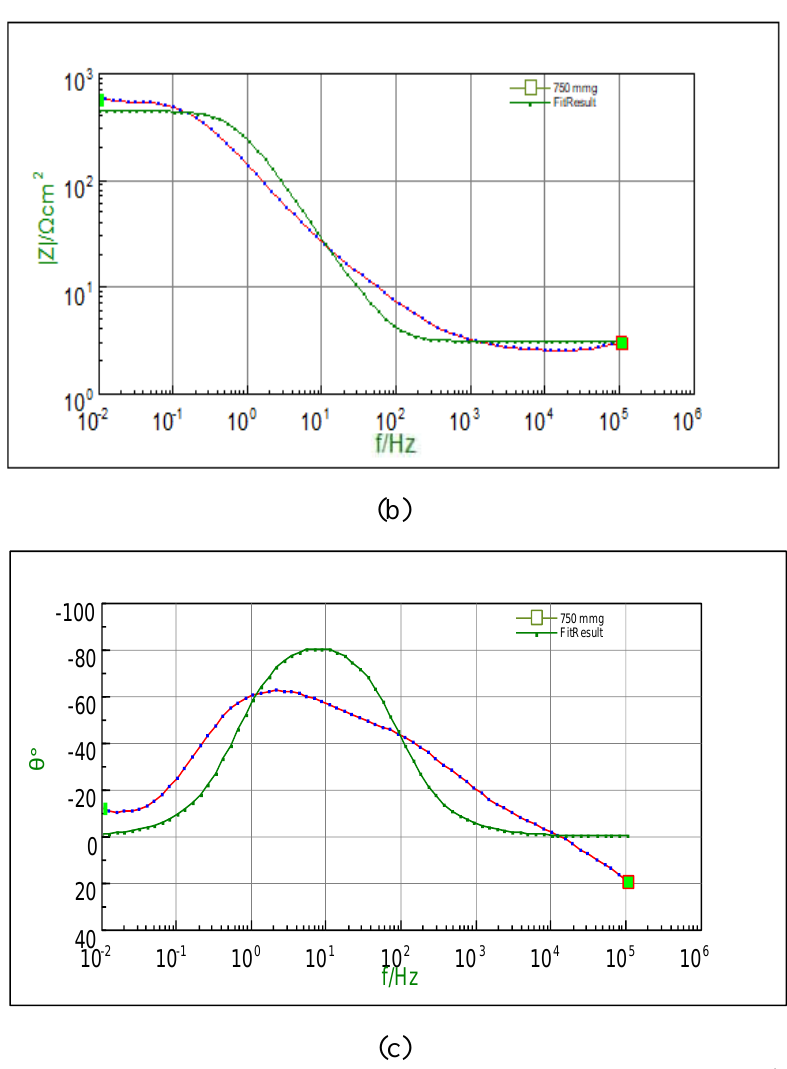
Fig. 13. The EIS test for 750 mg/l concentration of inhibitor at 45◦C with the fitting result. (a) Nyquist plot, (b, c) Bod (log versus |z|), and phase angle (log f versus ∝ 𝟎 )